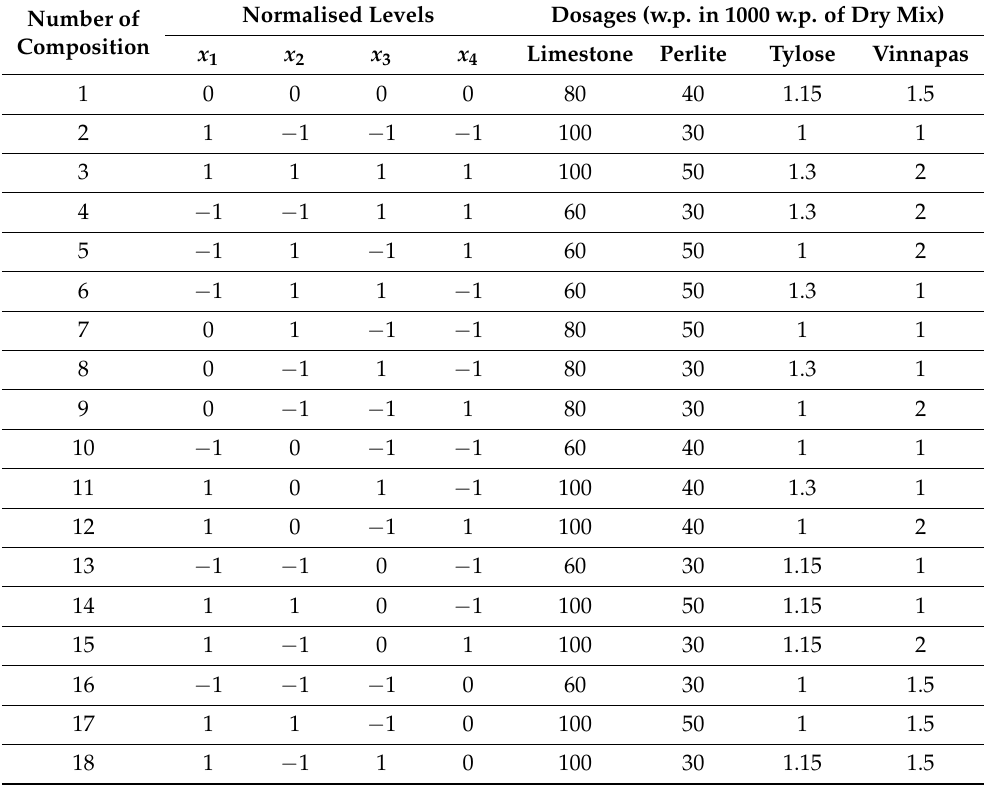
Table 2. Levels of composition factors in the experiment. Number